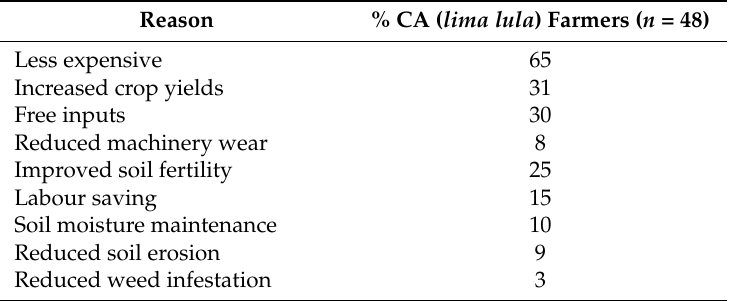
Table 7. Motivating factors for practise of conservation agriculture given by the sampled CA smallholder farmers of the Eastern Cape Province.